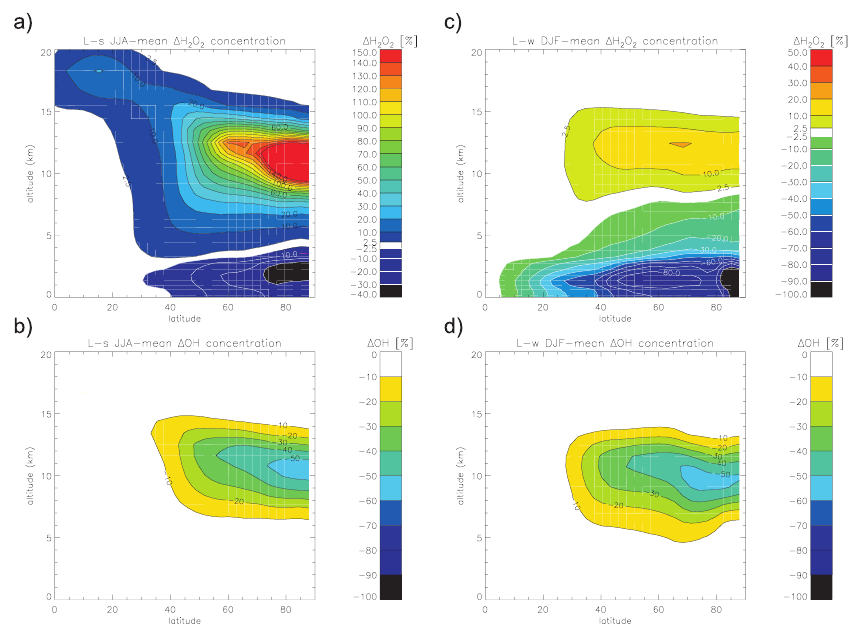
Fig. 5. Simulated relative changes in zonal 3-month mean H 2 O 2 and OH concentrations averaged over the Northern Hemisphere for (a) L-s